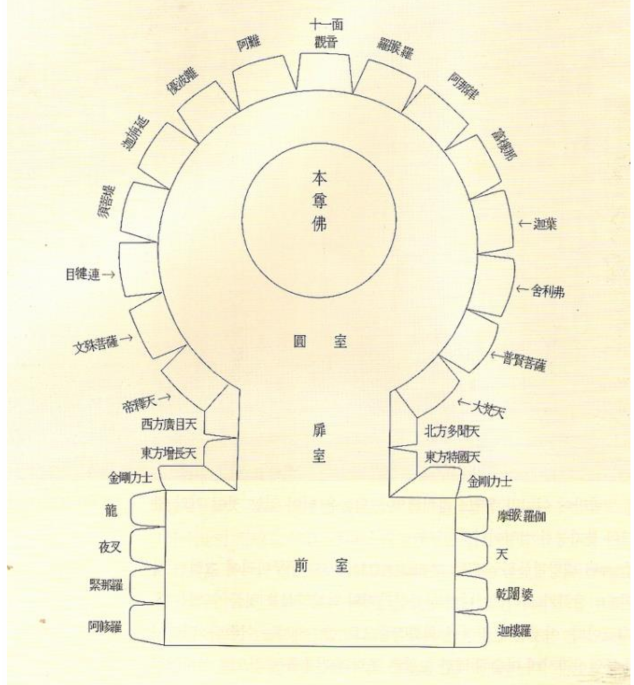
Figure 19. Plan of Seokguram indicating (in Chinese) the many different guardians and protective figures (four kings and arahats) that surround the Buddha in carved reliefs. Chinese names are given.